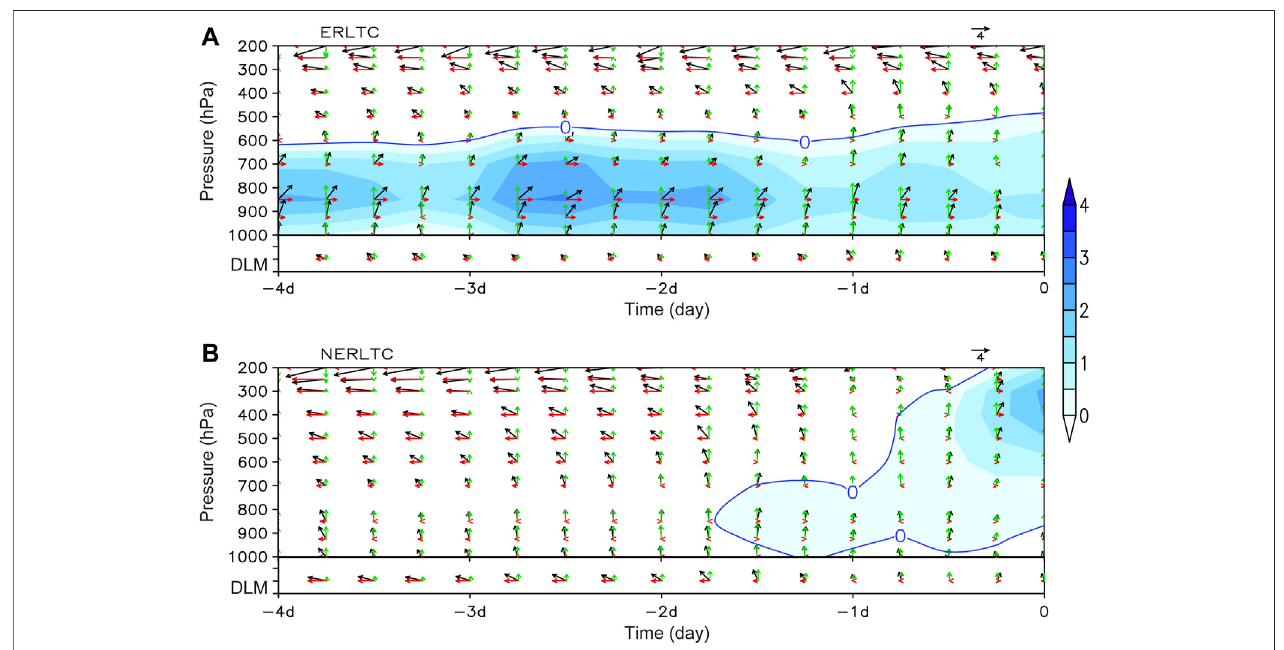
FIGURE 11 | Environmental steering fl ow at different heights and the DLM for the (A) ERLTCs and (B) NERLTCs, including the total wind speed (black vectors; units:m s − 1 )themeridional(greenvectors;unit:m s − 1 )andzonal(redvectors;units:m s − 1 )componentsofthesteering fl owandtheDLMsuperimposedonthetemporal evolution of the zonal zero wind-speed line (blue line; units: m s − 1 ). Areas with zonal steering air fl ow greater than zero are shaded.